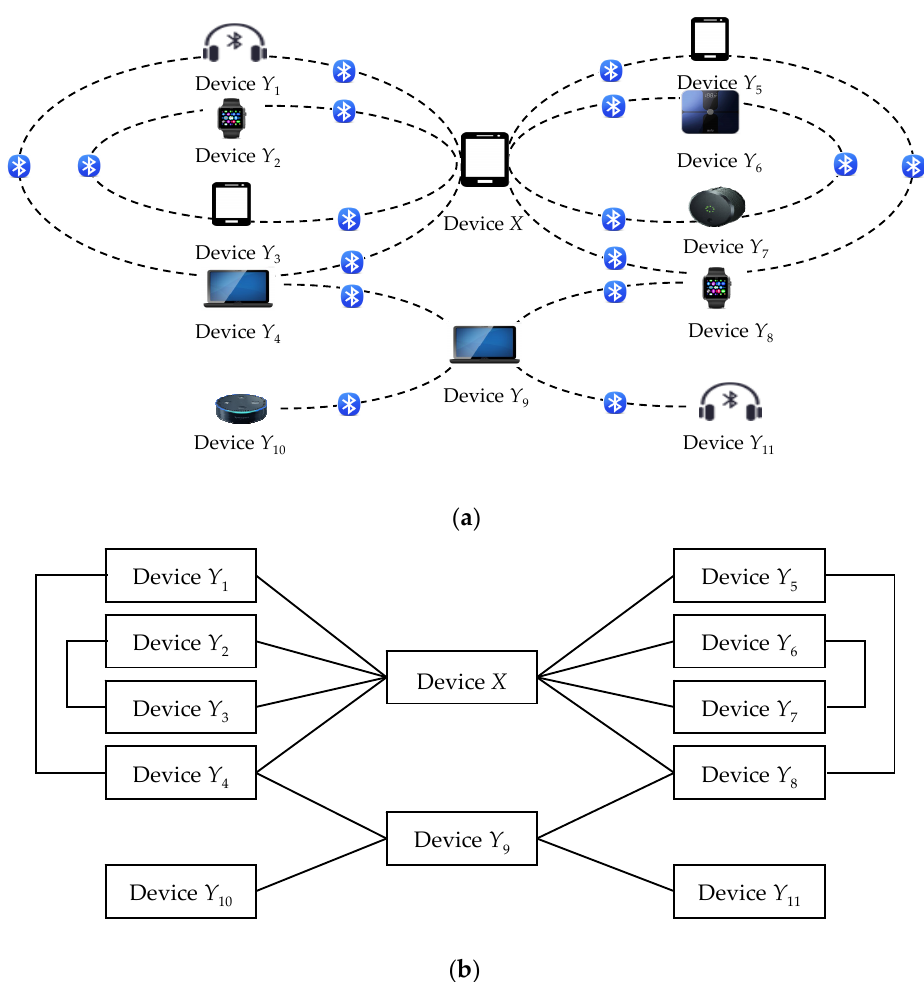
Figure 5. An example of the extended privacy attack: ( a ) The communication activities of multiple tracked devices; ( b ) The tracked devices’ communication constellation derived from Figure 5a.